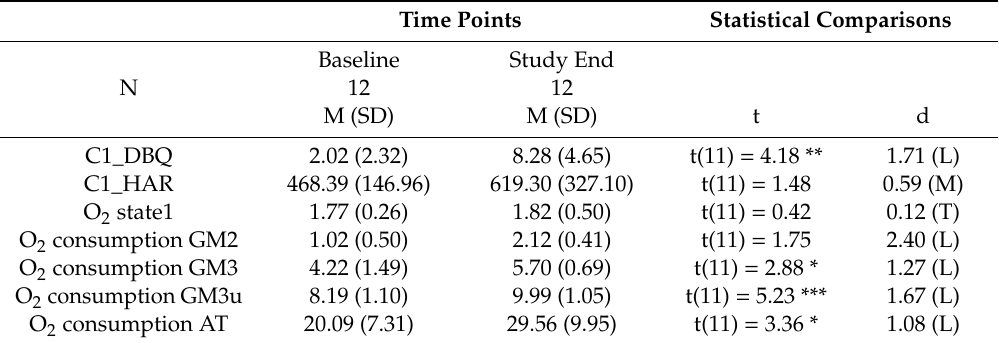
Table 3. Descriptive and statistical indices of mitochondrial activity at baseline and study end in individuals with burnout. Time Points Statistical Comparisons Baseline Study